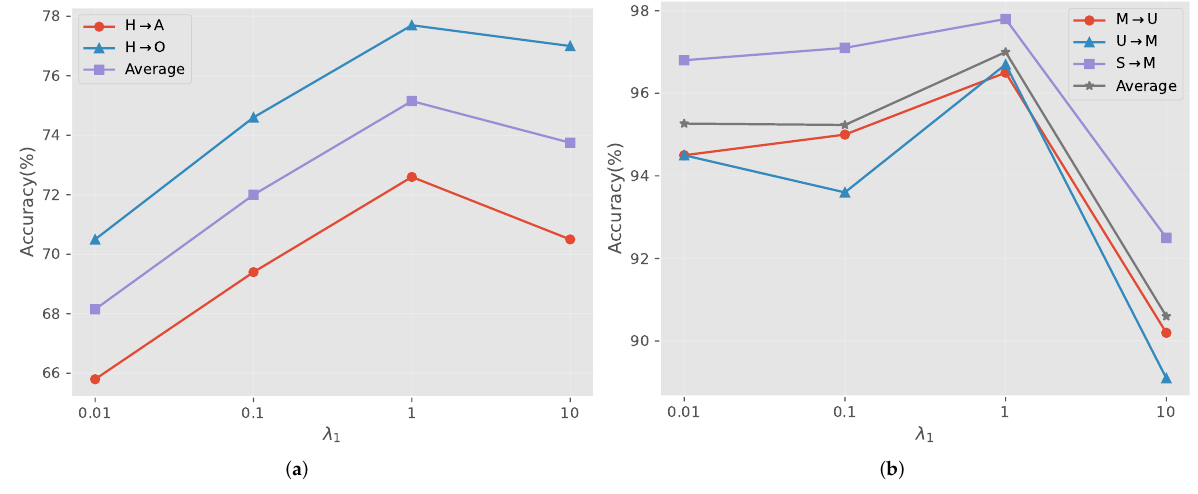
Figure 3. The effect of hyperparameter λ 1 on BCC and Digts datasets. ( a ) BCC, ( b ) Digts.